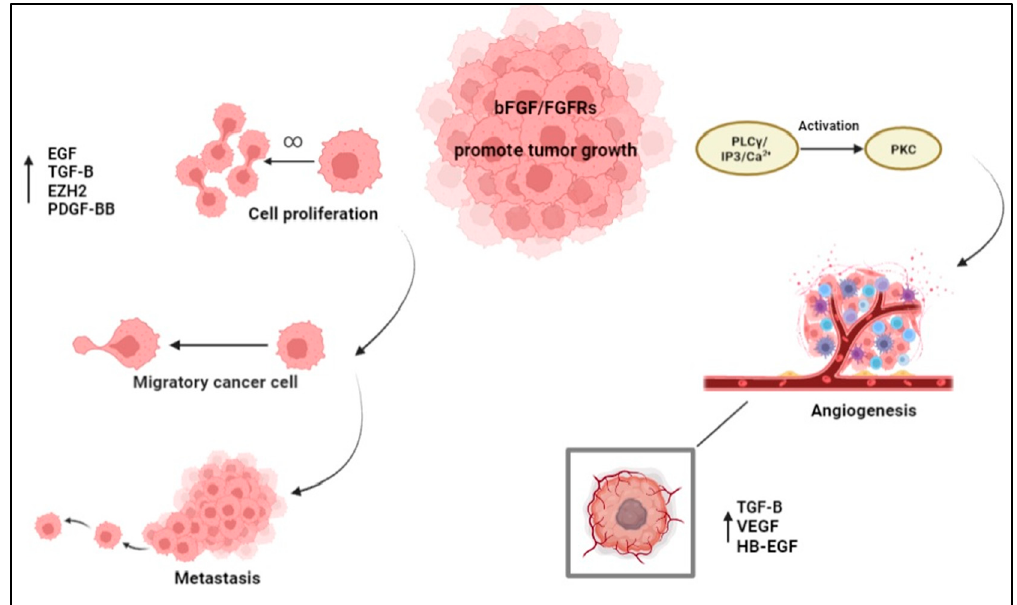
Figure 1. bFGF driving tumor evolution and spread. The figure presents the biological mechanisms controlled by bFGF, which contributes to both cancer cell growth and migration in other body districts, largely through neoangiogenesis